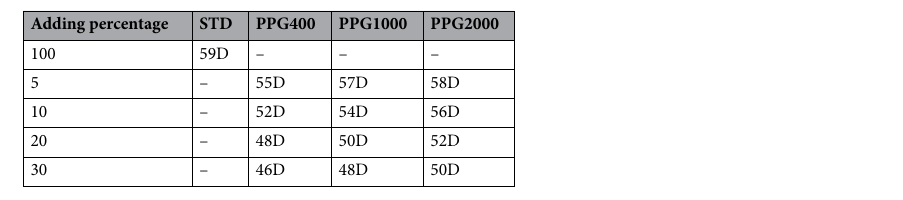
Table 1. Shore hardness of formulated resin